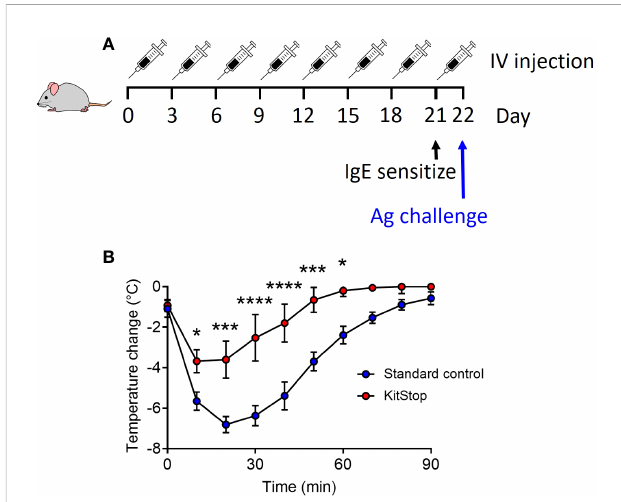
data indicate that KitStop treatment signi fi cantly reduces the severity and duration of the anaphylactic response in a mouse model of passive systemic anaphylaxis, and does not overtly affect